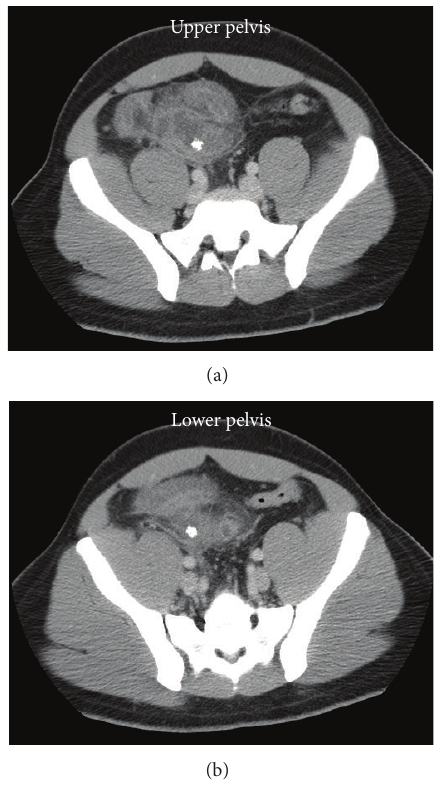
Figure 1: Extensive inflammatory changes in the right lower quadrant associated with an intraperitoneal calcification—common findings in acute appendicitis with a fecalith.